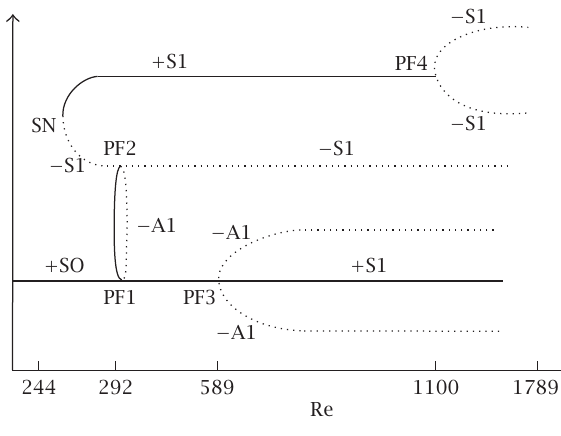
Figure 4.3. Schematic bifurcation diagram for Re <